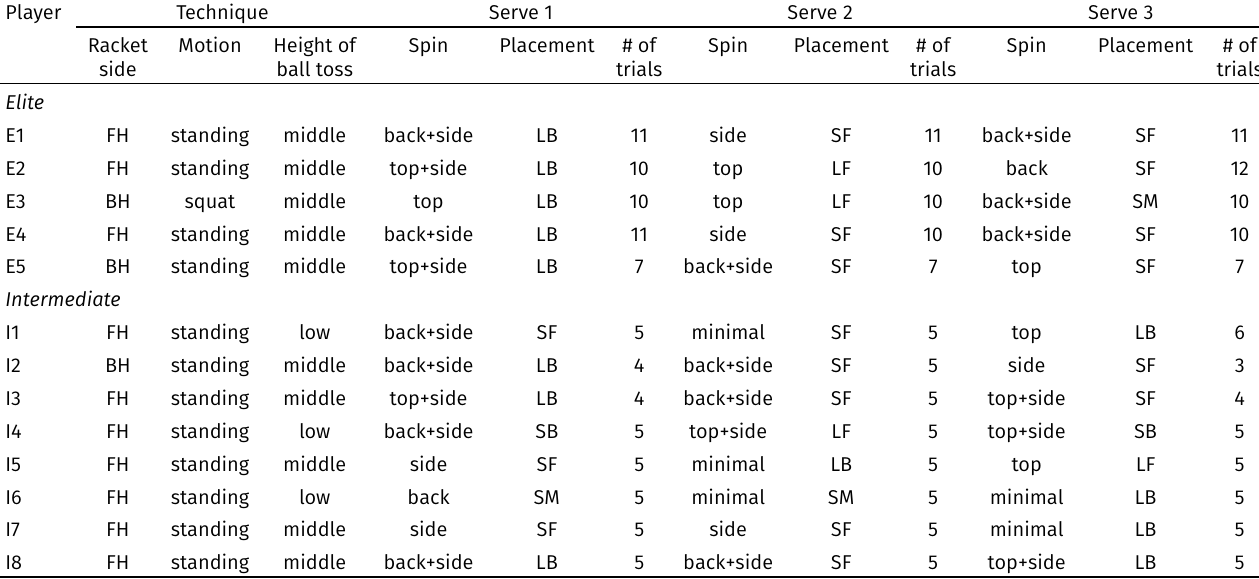
Table 1. Technique, spin, placement and number of trials for three types of services performed by each player. Player Technique Serve 1 Serve 2 Serve 3 Height of Placement # of Placement # of Spin Placement # of ball toss trials trials trials